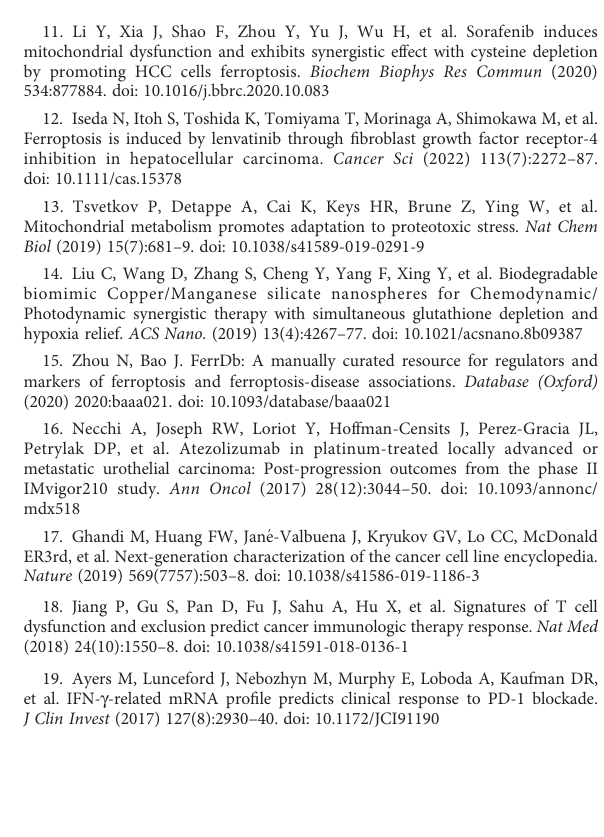
SUPPLEMENTARY FIGURE 1 Assessment of the prognostic signature (CRFs) in GSE144269. (A) survival status distribution (B) PCA plot. (C) t-NSE plot. (D) timeROC curve of risk score. (E) KM curves of OS.